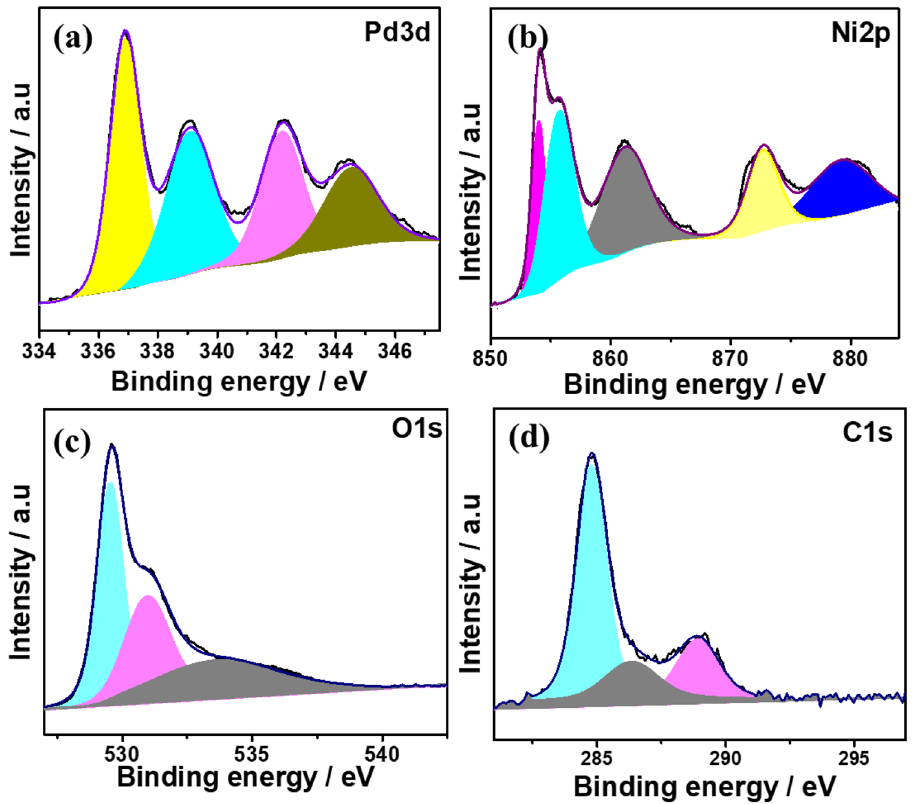
Figure 2. High resolution X-ray photoelectron spectroscopy ( a ) Pd 3 d , ( b ) Ni 2 p , ( c ) O 1 s and ( d ) C 1 s spectra of PdO–NiO